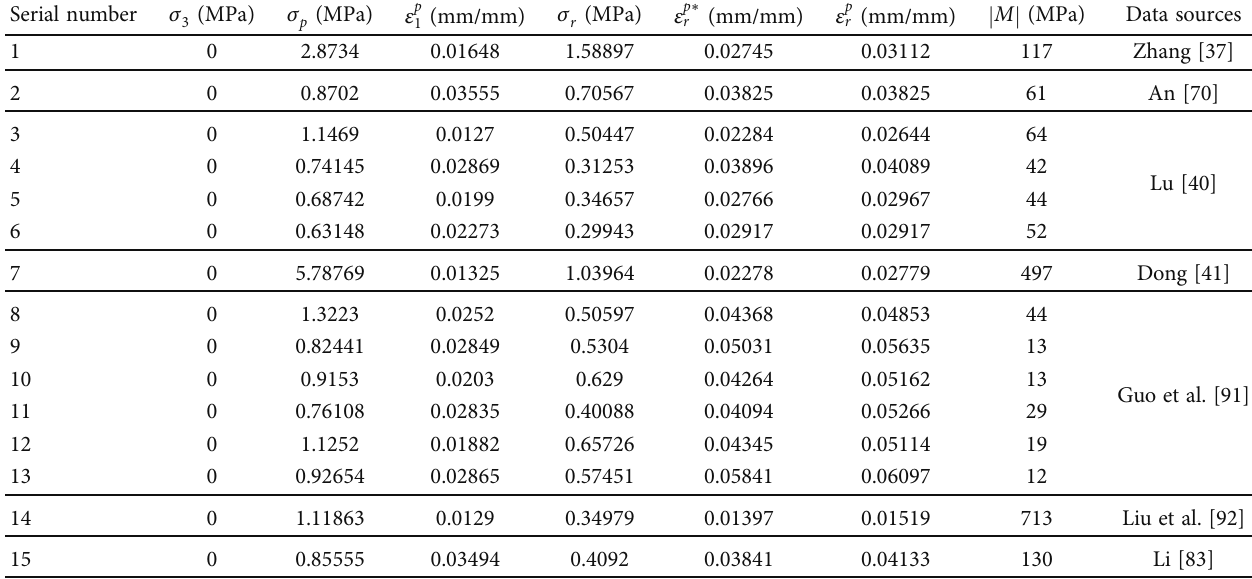
Table 4: Mechanical parameter statistics of complete stress-strain curves of briquette composed of soft coal during the uniaxial